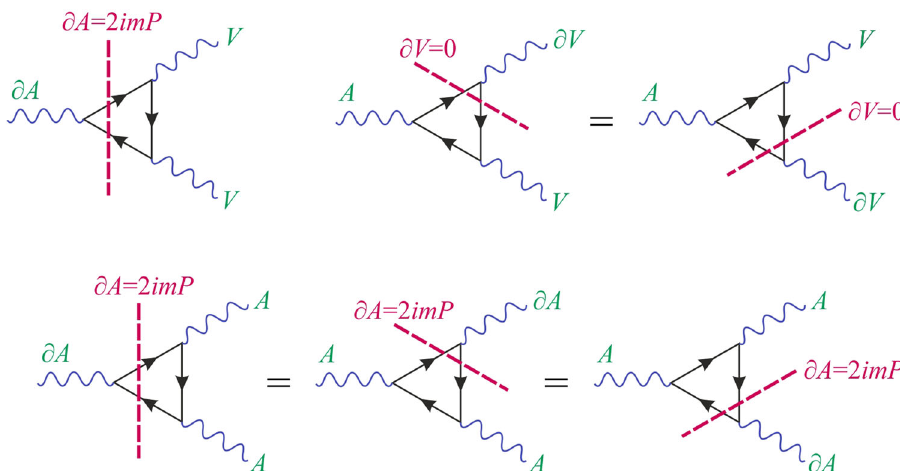
Fig. 2 Non–anomalous Ward identities valid for the mass-dependent terms of the triangle amplitudes. The dashed lines denote the cuts along which the fermionic equation of motion is